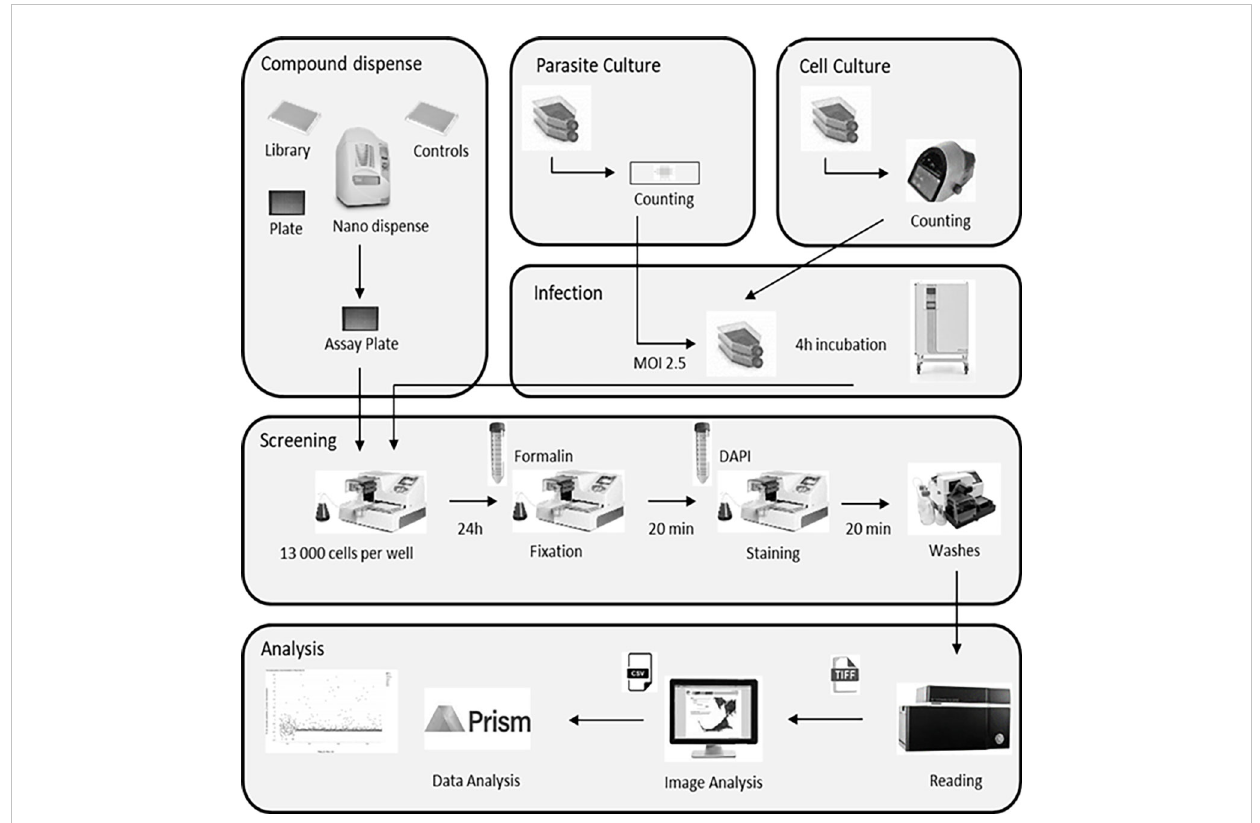
FIGURE 2 Assay work fl ow showing all steps of the library screening protocol, namely cell culture, parasite infection, sample processing and labeling, and image acquisition followed by automated image analysis. MOI, multiplicity of